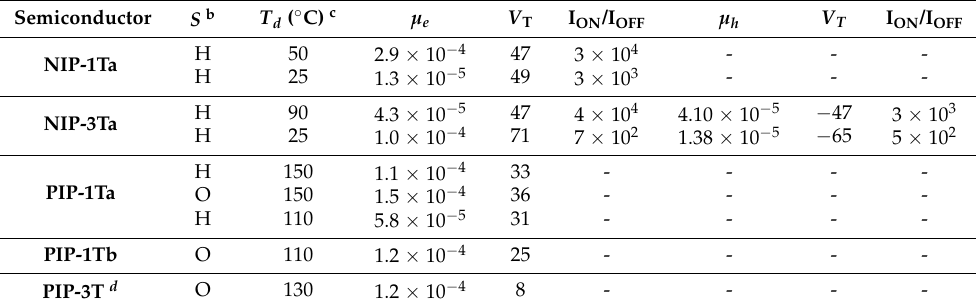
Table 7. OFET electrical data for vapor-deposited films of NIP-1Ta , NIP-3Ta , PIP-1T and PIP-3T measured under vacuum on vapor-treated Si/SiO 2 substrates. Average field-effect mobilities are shown a